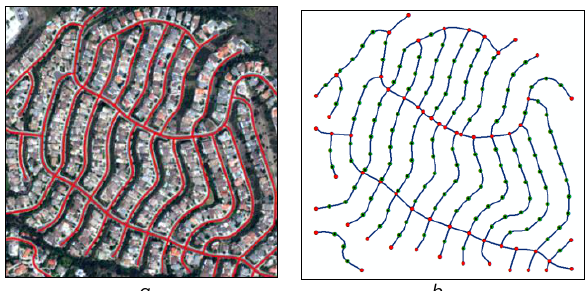
Figure 2. First study area. a) Road network extraction result overlaid on the RGB bands of the worldview-2 image; b) Selected points for topological evaluation of the extracted road network. Green points are some equidistance points and red points are junctions and endpoints.